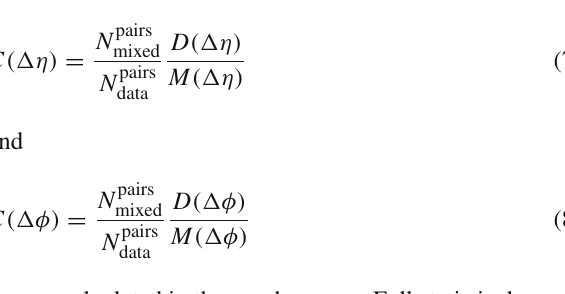
models do not incorporate HBT + Coulomb + FS